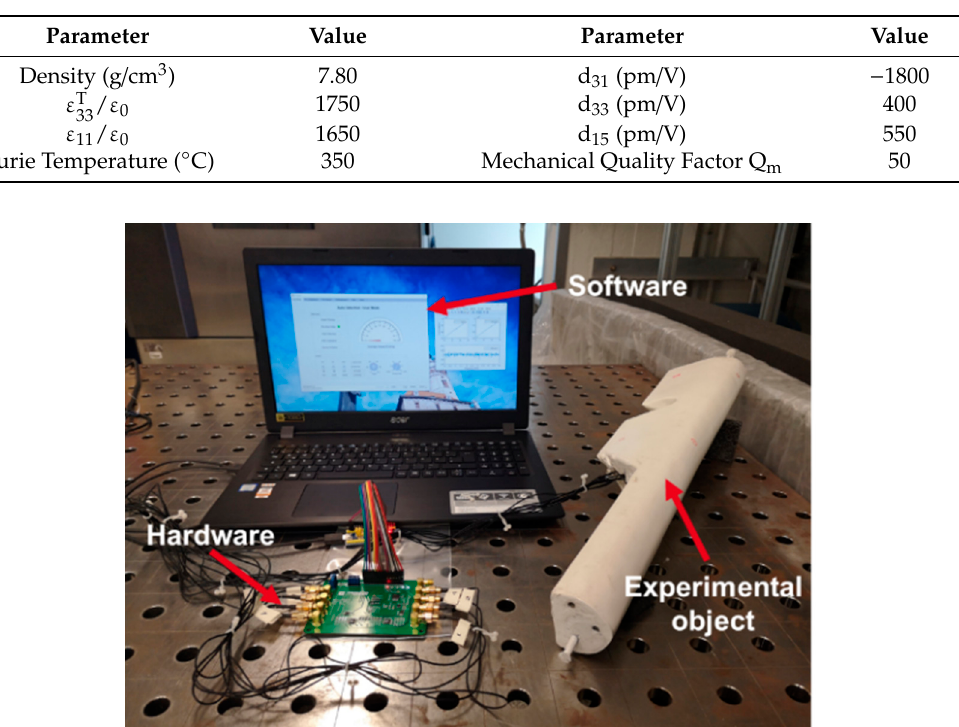
Figure 13. The designed SHM system in experiments.